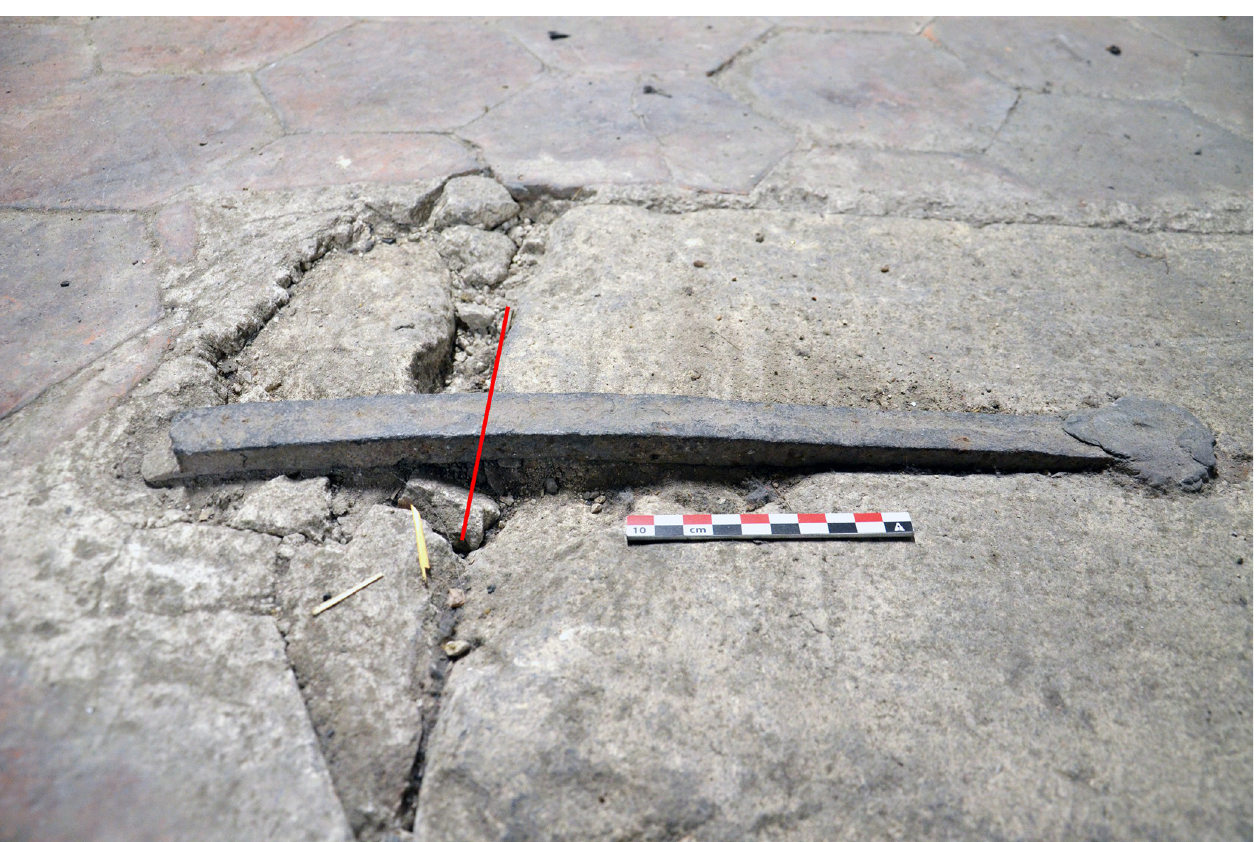
Fig 6. Broken staple in the tribunes (TRIB01S). The red line indicates the sampling. The sample was then cut longitudinally for analysis.